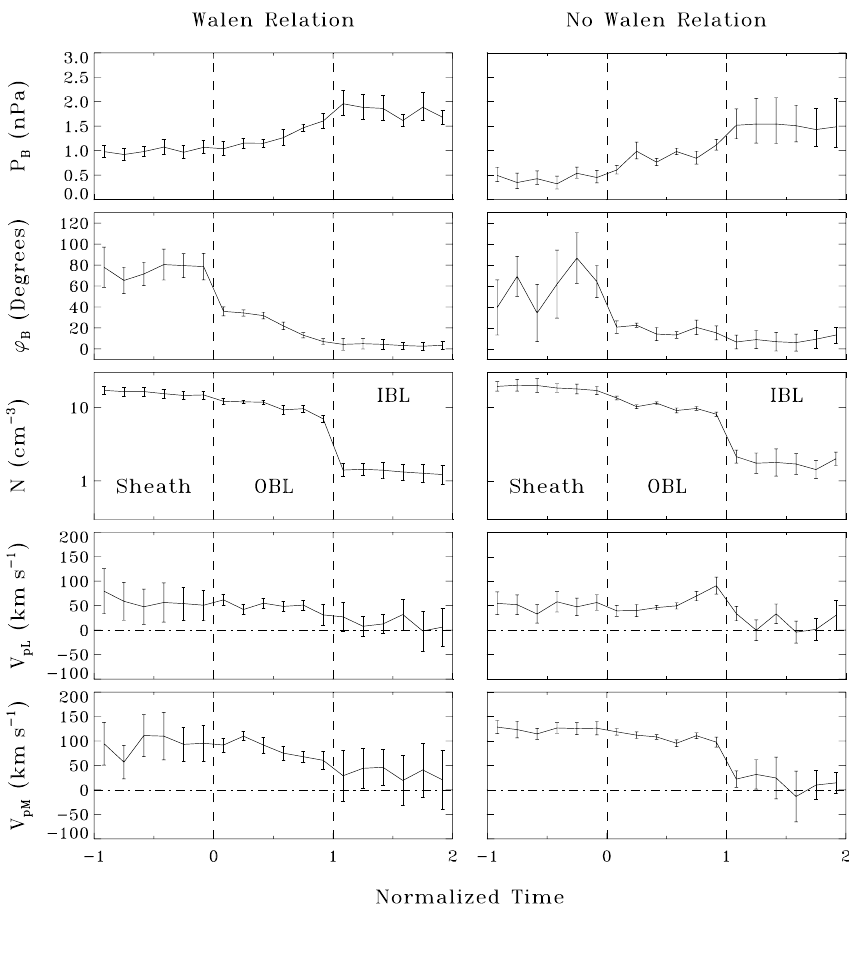
Fig. 4. Superposed epoch analysis of the magnetic pressure, P B , the mag- netic field rotation angle, ϕ B , the to- tal plasma density, N , and the compo- nents V pL , V pM of the proton bulk ve- locity across the outer boundary layer. The sign of V pL is reversed for cross- ings at southern latitudes and the sign of V pM is reversed for crossings duskward of local noon. The left panels display data from 11 crossings that show rea- sonable agreement with the Wal´en rela- tion, and the right panels display data from 11 crossings without agreement. Normalized time ˆ t = 0 corresponds to the magnetopause and normalized time ˆ t = 1 corresponds to the interface be- tween the OBL and the IBL. Vertical er- ror bars indicate the standard deviation of the average of each